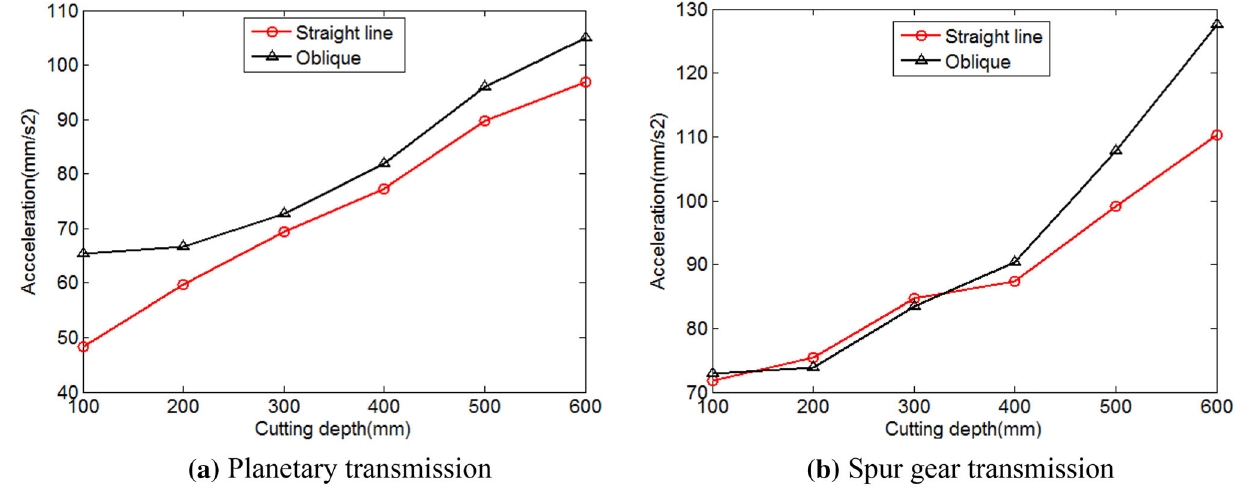
Fig. 7 Comparison of peak vibration accelerations between oblique and straight line